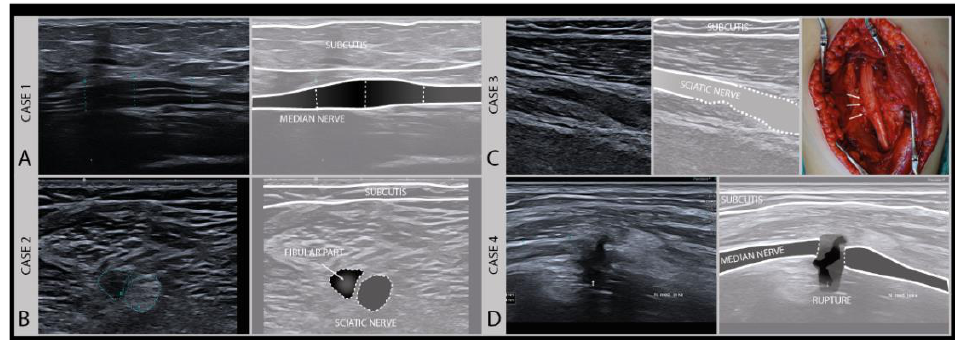
Figure 6. Examples of different degrees of axonal damage. Case 1 ( A ): median nerve swelling following local trauma (fracture), fascicles intact, full recovery without surgery (Sunderland II). Case 2 ( B ): heterogeneous lesion of the sciatic nerve (peroneal part) of a 19-year-old boy after a scooter accident. Case 3 ( C ): sciatic nerve damage (Sunderland III) in a 9-year-old girl after a severe car-accident (high-frequency 9–18 MHz). (Intraoperative image kindly provided by PD. Dr. F. Lassner). Case 4 ( D ): iatrogenic median nerve lesion with loss of nerve continuity (Sunderland V) in a 53-year-old man after arthroscopy of the elbow joint (high frequency 19–24 MHz).